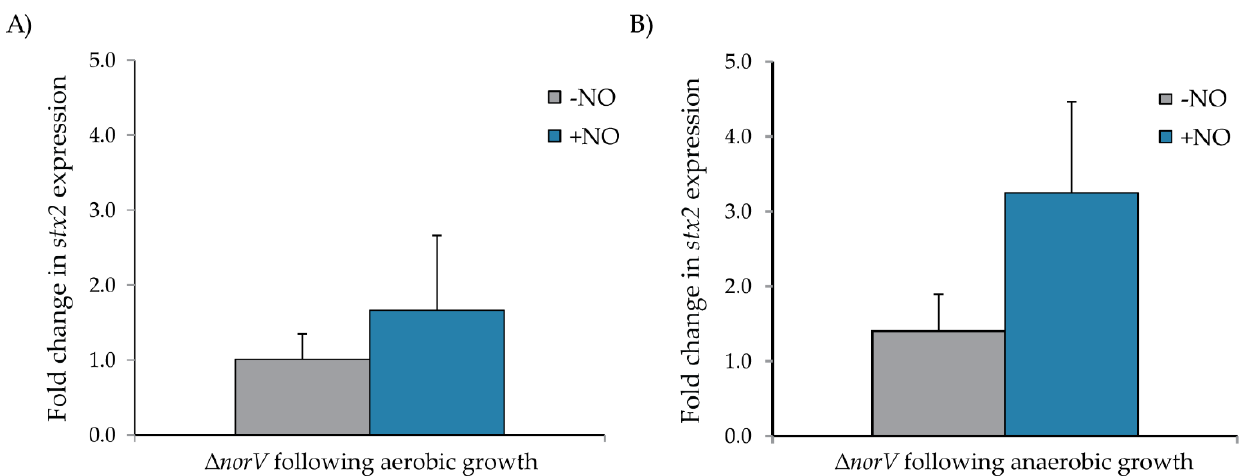
Figure 3. Fold change in stx2 gene expression in ( A ) aerobic and ( B ) anaerobic conditions with and without nitric oxide (NO) in the null ∆ norV mutant strain relative to the wild-type (WT) TW14359 O157:H7 strain. The stx2 transcripts in each condition were normalized to the amount of 16S transcripts and are shown relative to the level of transcription in the WT for each growth condition. The boxes represent the means of at least three independent experiments and the bars are the standard deviation of the means. A fold-change ≥2 was considered biologically significant.